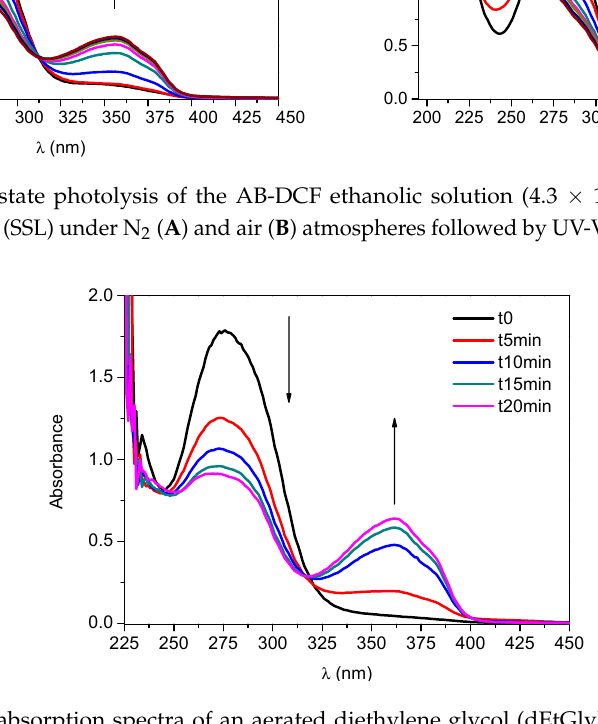
Figure 3. UV-Vis absorption spectra of an aerated diethylene glycol (dEtGly) solution of AB-DCF (6.6 × 10 − 5 M) irradiated using SSL.